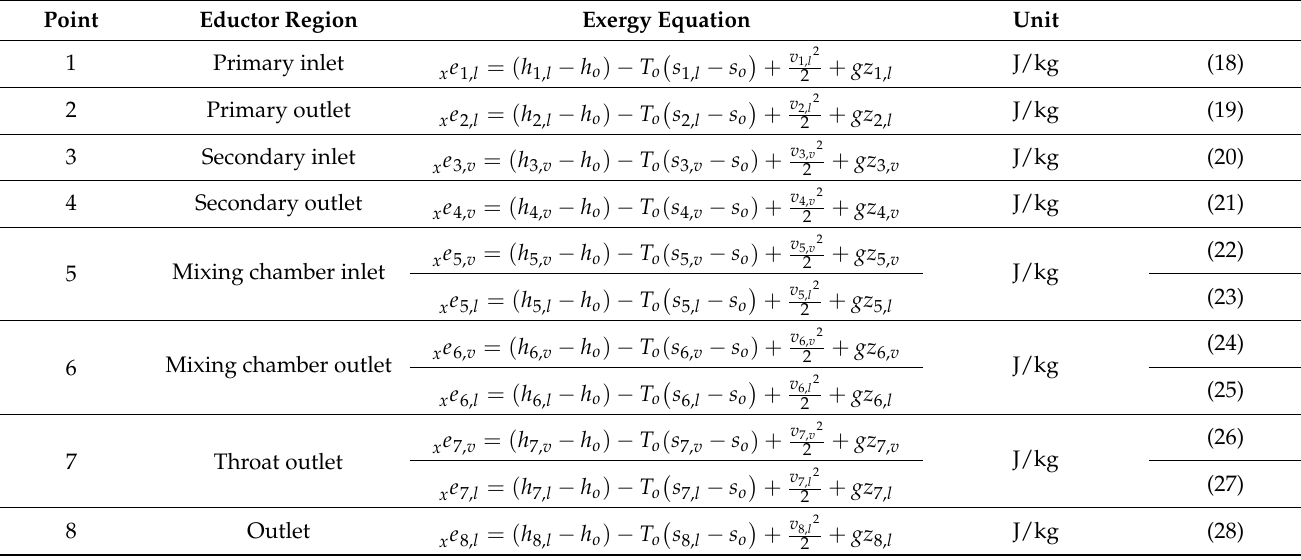
Figure 6. Physical model for exergy analysis of eductor. The specific exergy equations for an eductor are described in Table 2. Table 2. Specific exergy at various point in the eductor.